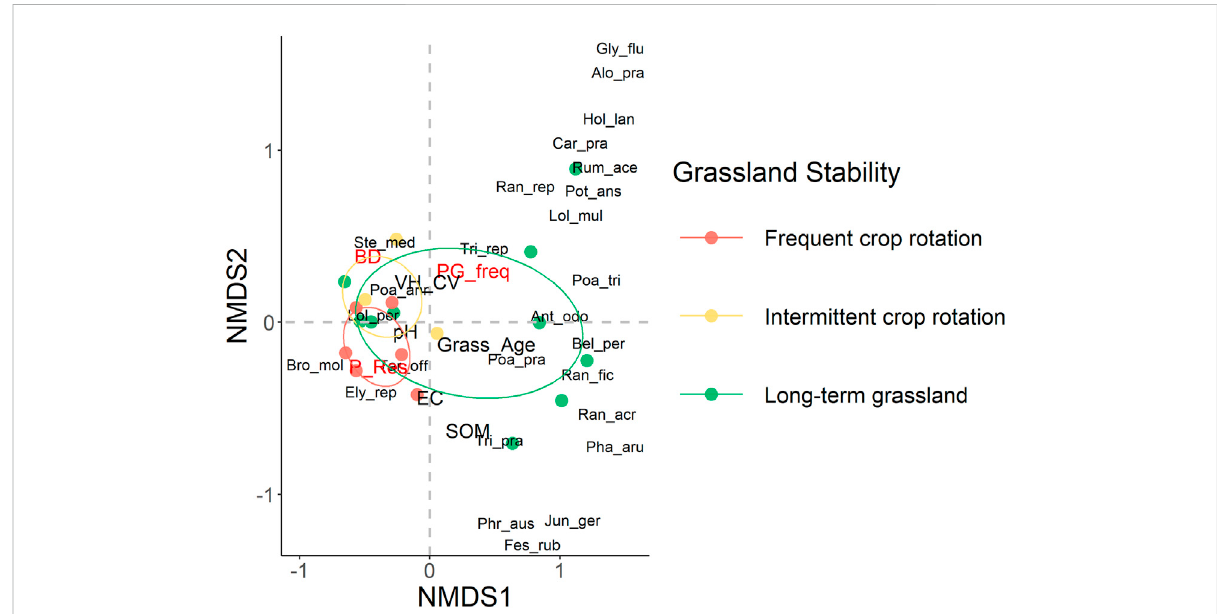
FIGURE 5 Grassland plant community ordination plot with results of non-metric multidimensional scaling analysis (NMDS) of abundance data (see Supplementary Table S6 in Supplementary Material for full species names). Environmental variables are fi tted to visualize their correlation with the ordination: soil bulk density (BD), cumulative years as a permanent grassland (PG_freq), years since last conversion (Grass_Age), soil penetration resistance (P_Res), soil organic matter content (SOM), coef fi cient of variation in plant height (VH_CV), electroconductivity (EC), and pH. Environmental variables signi fi cantly correlated ( p < 0.05) with the ordination are indicated in